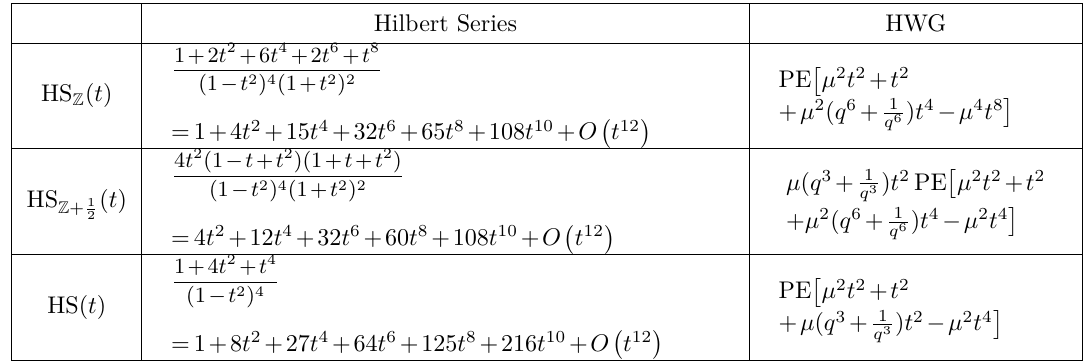
Table 12. Hilbert series for the E 3 magnetic quiver (3.8), representing the O su (3) cone in O e 3 . min min The first line of the table provides the Hilbert series when the GNO magnetic lattice is integer HS Z ( t ) , the second line shows the sum over the integers-plus-half lattice HS Z ( t ) and the last + 1 2 line is their sum HS( t ) . In the third column, we show the HWG in terms of fugacities for su (2) (denoted µ ) and u (1) (denoted q ). Note that the q -charge is normalized, such that the branching of su (3) → su (2) × u (1) is ( µ 1 ) 7→ q +1 ( µ ) + q − 2 su (3) su (2)